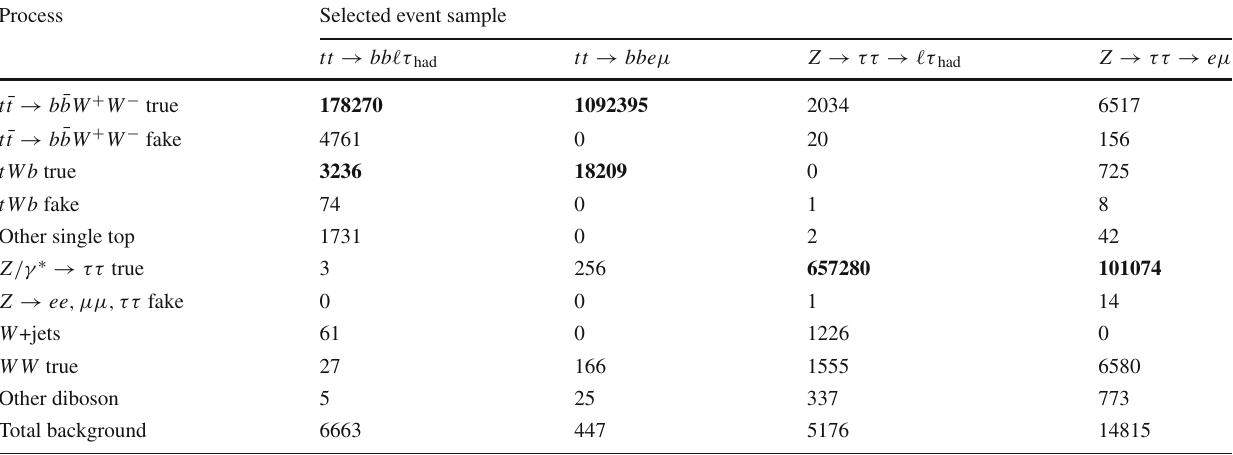
Table 3 The expected numbers of events in the four selected event (cid:2) √ L d t = 140 fb − 1 at s = 13 TeV. The numbers are bro- two correctly identified leptonic W boson decays are included in the tt samples for “true’ category. Otherwise, the events from t ¯ tV processes are included ken down by physics production process. The numbers for tt , single top in the tt “fake” category. The numbers given in bold type represent and Z boson production are further broken down into the two categories the signal in the four selected event samples. The numbers given “true”, in which the two lepton candidates are correctly identified, and “fake”, in which at least one of the lepton candidates is incorrectly